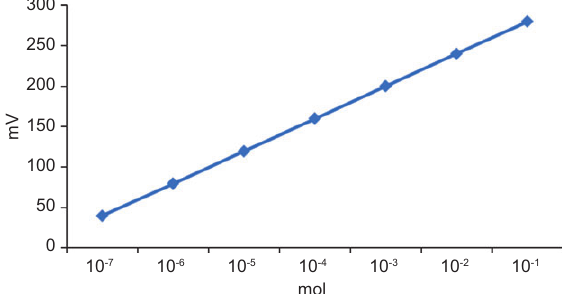
Figure 2 Cadmium metal sensors ’ response.